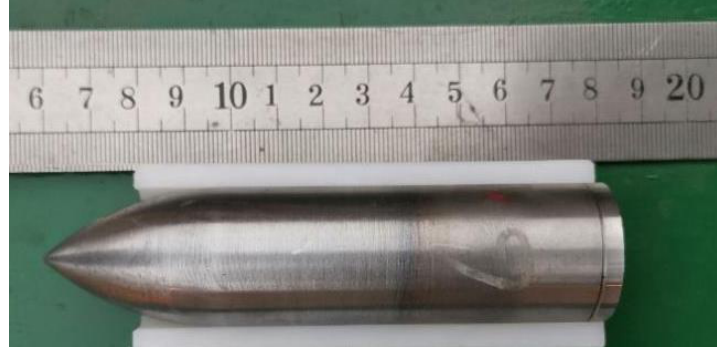
Figure 6. A 30 － mm alloy steel projectile with an ogival nose. Figure 6. A 30-mm alloy steel projectile with an ogival nose.